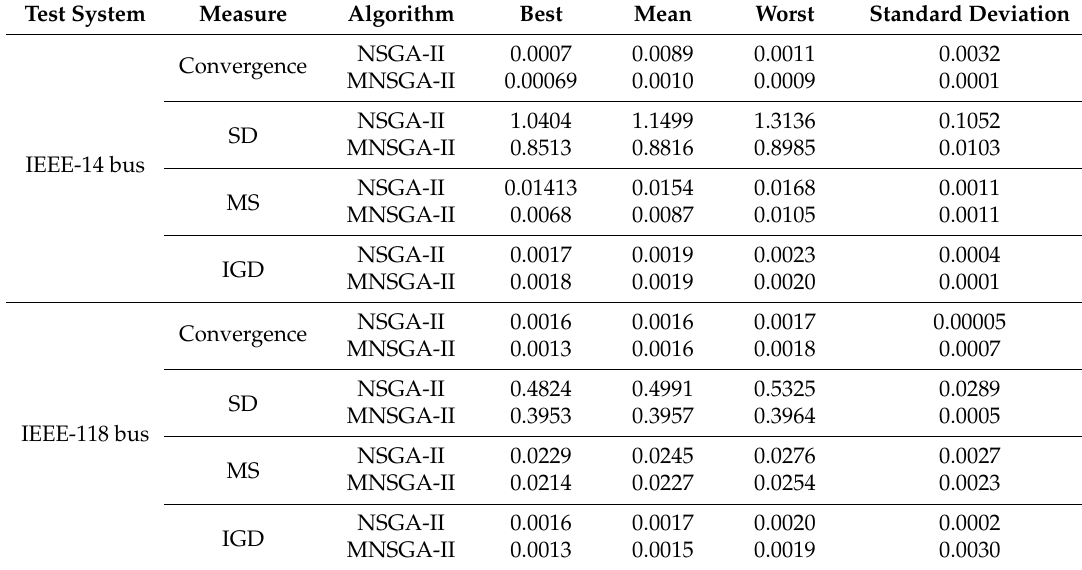
Table 5. Statistical results of performance measures.